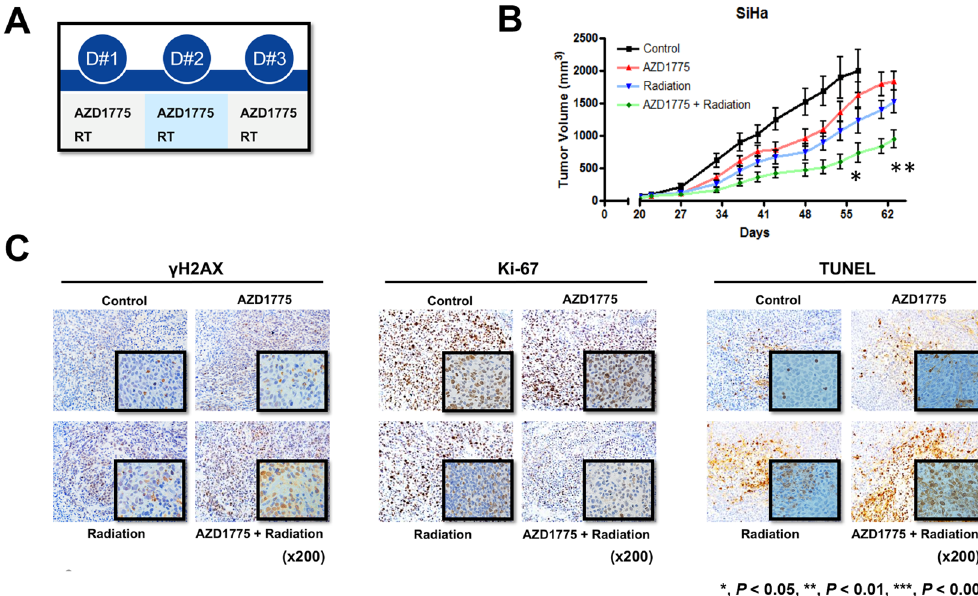
Figure 5. Combination effect of AZD1775 and IR in SiHa cell xenografts. Athymic nude mice bearing SiHa xenografts in their flanks were treated with AZD1775 (60 mg/kg; oral, one a day; 1 h before IR for 3 days) and IR (2 Gy/fraction for 3 days), as illustrated ( A ). Treatment started when the average tumor volume reached 100 mm 3 in all groups. Tumor volume (TV) was calculated according to the equation: TV = π /6 (ab 2 ), where a and b are the long and short dimensions of the tumor. Mice were euthanized at 120 days post tumor injection, or when tumor volume reached at 1000 mm 3 , or when the mice were in a moribund condition, whichever occurred first. Tumors were excised at the time of euthanasia ( B ). Immunostaining of γ H2AX and Ki-67 and TUNEL assay ( × 200) were performed ( C ). The error bar represents standard error of the mean